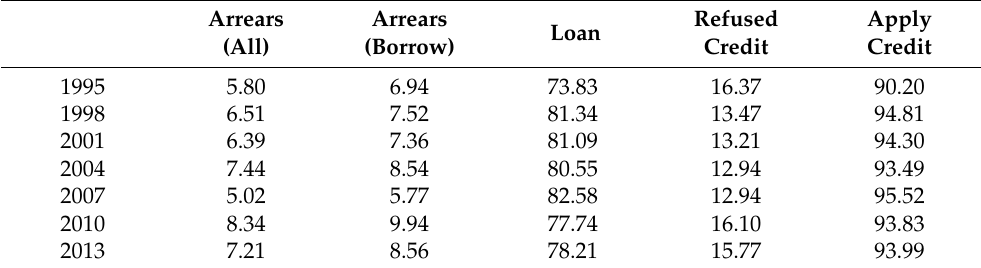
Table 2. Comparing Borrowing and Arrears Across